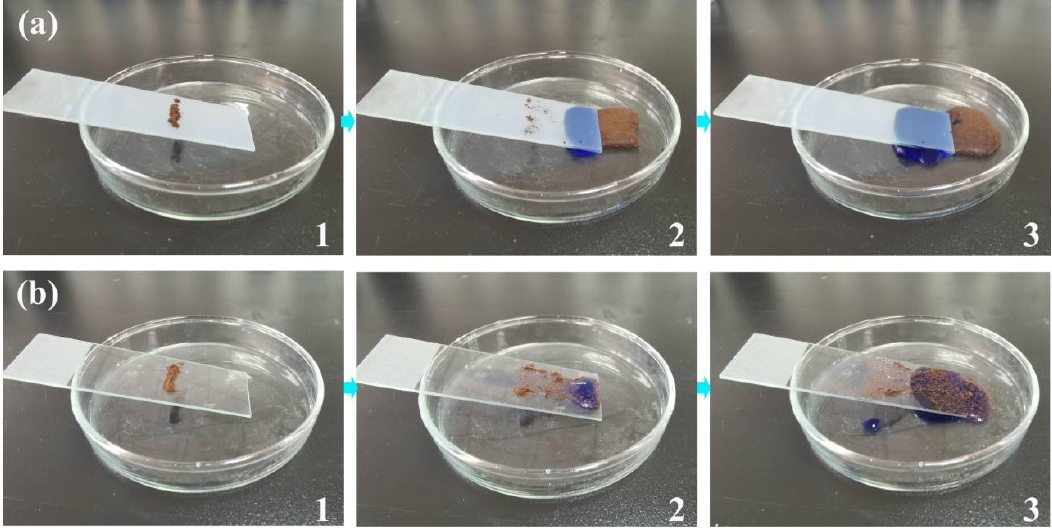
Figure 9. Self-cleaning capability of ( a ) P 40 –P 4 –P 0.4 superhydrophobic glass slide and ( b ) glass